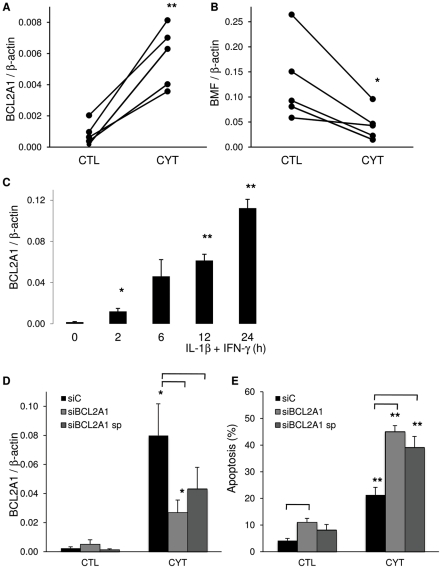
IL-1β+IFN-γ modifies BCL2A1 and BMF expression.(A, B) RNA-seq data were validated for BCL2A1 and BMF by qRT-PCR in 5 independent human islet preparations exposed or not (CTL) to the cytokines IL-1β+IFN-γ (CYT). Data were normalized to expression levels of the housekeeping gene β-actin. (C) INS-1E cells were left untreated or treated with IL-1β+IFN-γ for different times. BCL2A1 expression was assayed by qRT-PCR and normalized for β-actin expression. The results are means ± SEM of 4 independent experiments. (D, E) INS-1E cells were transfected with control siRNA (siC, black bars) or either a single or a combination of 4 siRNAs (smart pool, sp) targeting BCL2A1 (siBCL2A1, grey bars). After 48 h, cells were exposed to IL-1β+IFN-γ (CYT) for 16 h. (D) BCL2A1 expression was measured by qRT-PCR and normalized for β-actin expression. Results are mean ± SEM of 4 independent experiments. (E) Apoptosis was examined by fluorescence microscopy after staining with the DNA-binding dyes propidium iodide and Hoechst 33342. Results are mean ± SEM of 4 independent experiments. *p<0.05, **p<0.01 versus untreated control (CTL); p<0.05 for the comparison siC versus siBCL2A1 as indicated.